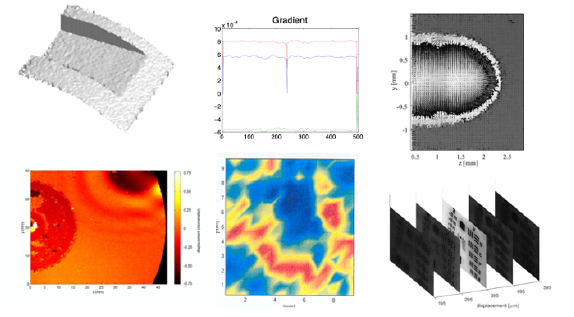
Fig. 1. Examples from various measurement results utilizing speckles